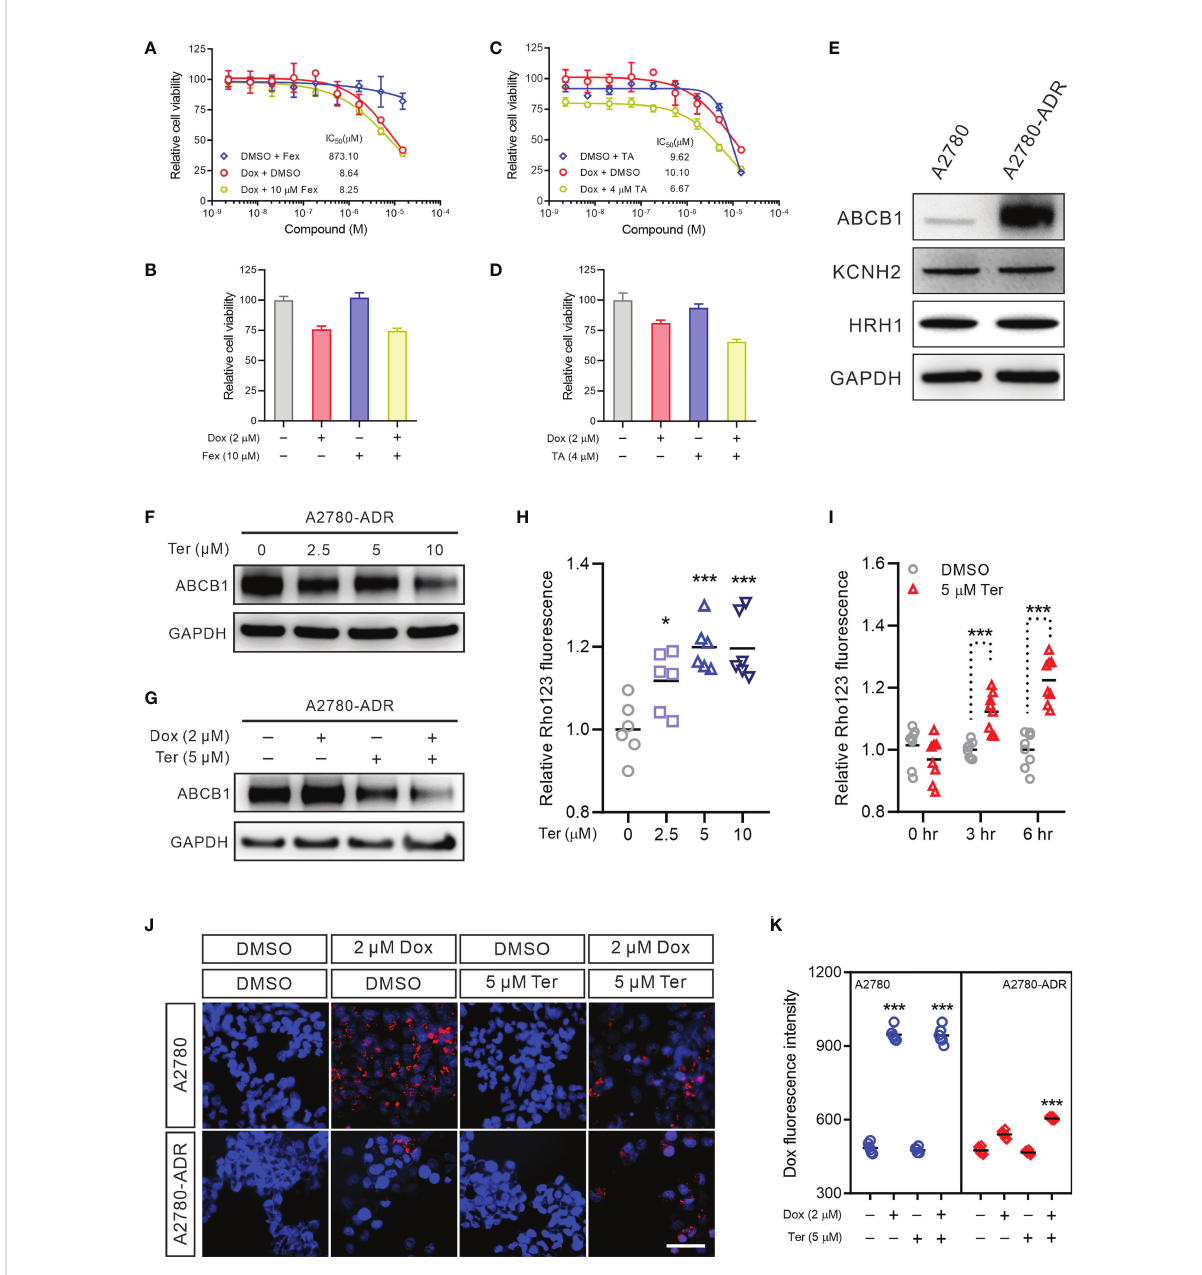
FIGURE 3 Terfenadine reverses MDR in ovarian cancer cells by repressing ABCB1 expression (A) Dose-response curves for doxorubicin (Dox) in the presence or absence of 10 m M fexofenadine (Fex) in MDR ovarian cancer cells. (B) Cell viability of MDR ovarian cancer cells treated with 2 µM doxorubicin (Dox), 10 µM fexofenadine (Fex), or both for 48 hours. DMSO was used as a non-treated control. (C) Dose-response curves of the MDR ovarian cancer cells to doxorubicin (Dox) in the presence or absence of 4 m M tannic acid (TA). (D) Cell viability of MDR ovarian cancer cells treated with 2 µM doxorubicin (Dox), 5 µM tannic acid (TA), or both for 48 hours. DMSO was used as a non-treated control. (E) Western blot analysis of hERG channel (KCNH2) and HRH1 in MDR ovarian cancer cell and its sensitive parental A2780 cell. (F) ABCB1 Western blot analysis in MDR cells treated with the indicated terfenadine (Ter) concentration. DMSO was used as a non-treated control. GAPDH was used as a loading control. (G) ABCB1 Western blot in MDR cells treated with 2 µM doxorubicin (Dox), 5 µM terfenadine (Ter), or both. DMSO was used as a non- treated control. GAPDH was used as a loading control. (H) Rho123 accumulation in MDR ovarian cancer cells treated with the indicated concentration of terfenadine (Ter) for 6 h. (I) Rho123 accumulation in MDR ovarian cancer cells treated for indicated time with 5 m M terfenadine (Ter). (J, K) Doxorubicin intracellular accumulation in MDR ovarian cancer cells or its parental sensitive A2780 cells treated for 6 hours with 2 µM doxorubicin (Dox), 5 µM terfenadine (Ter), or both. All values represent the mean ± SEM (n = 3 replicates). Western blot images were shown as one of three repeated experiments. Statistical analysis was carried out using a two-tailed t-test (* p < 0.05, *** p <